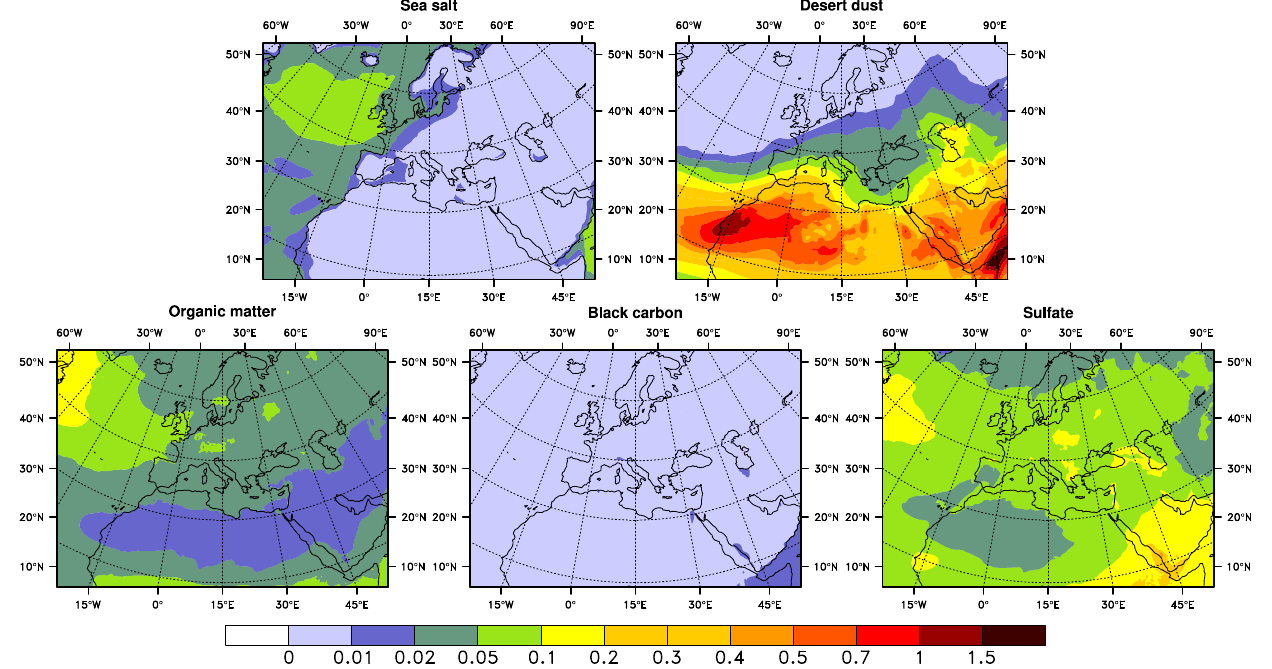
Table 3. Total AOD and components for the five aerosol types simulated by CNRM-RCSM5 and the MACC reanalysis in summer 2012 Figure 5. Mean aerosol optical depth at 550 nm in summer 2012 (JJA) simulated by CNRM-RCSM5 for the five aerosol types (sea salt, desert dust, organic matter, black carbon and sulphate).